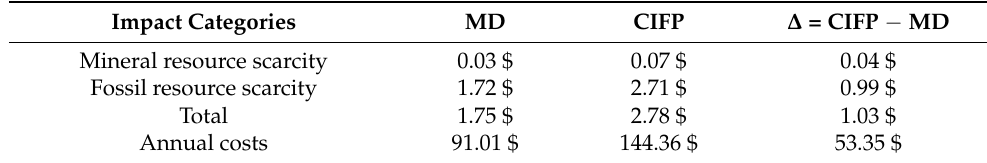
normal-weight adult).